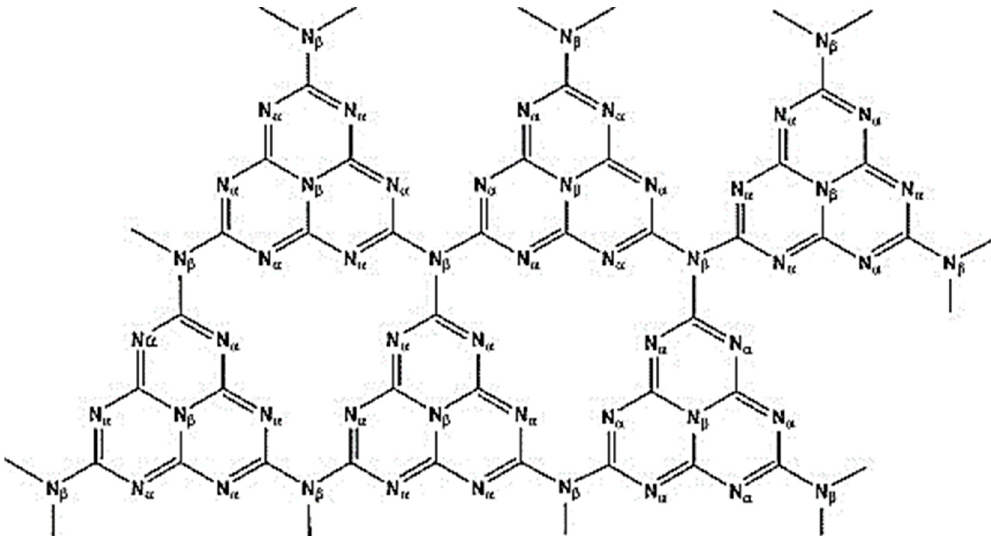
Figure 1. Structural orientation of a g-C 3 N 4 single layer. N atoms shifted under α and β varieties of locations [38].